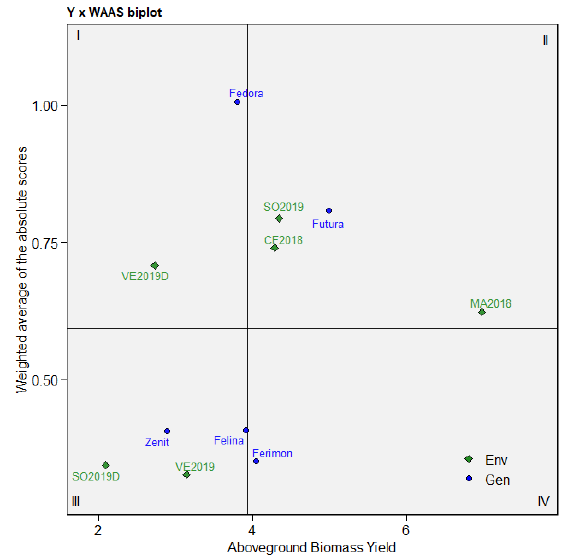
Figure 4. Biplot of the aboveground biomass yield (Mg ha −1 ) vs. the WAAS of 5 cultivars evaluated in 6 environments.